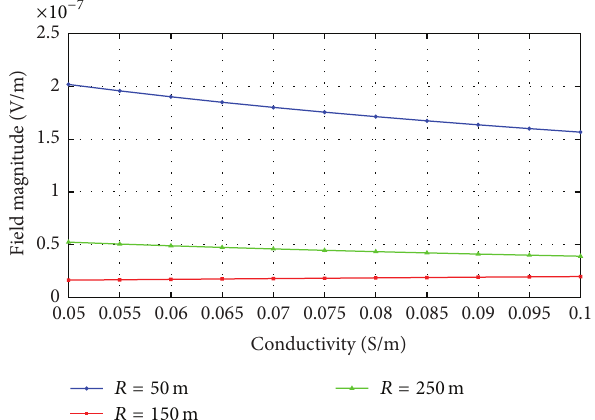
Figure 17: Curve of the radial component of the electric field magnitude with the relative permittivity.